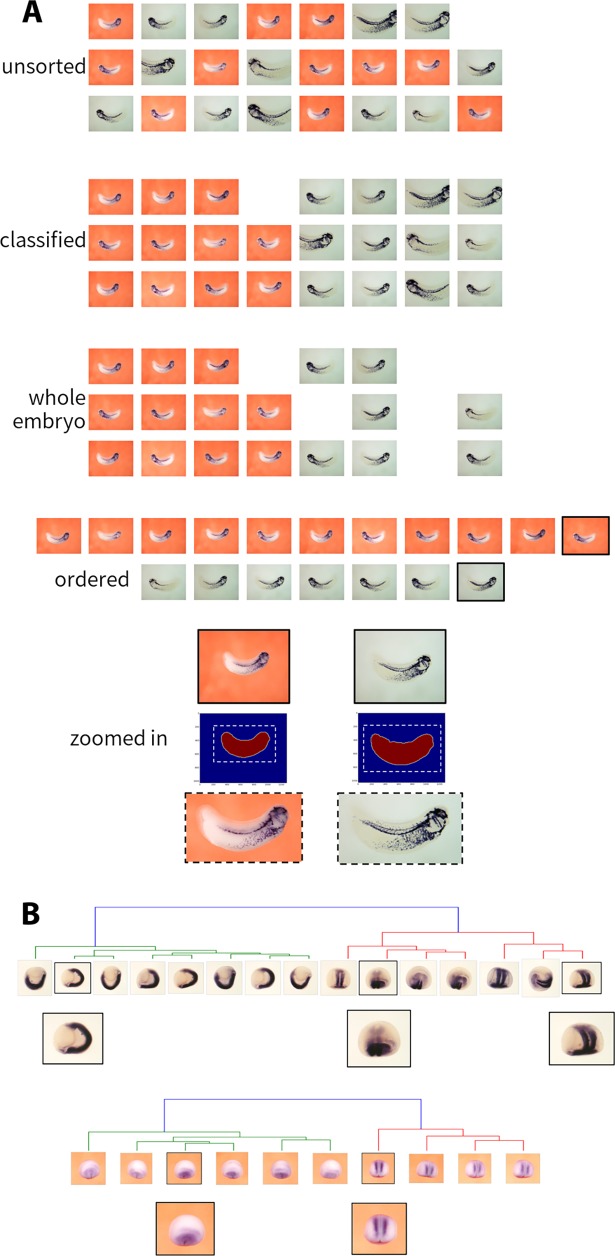
Rational selection of representative images to reduce redundancy.Unsorted images from a large collection for a given gene/development stage are first classified into cleared (grey background) and un-cleared (orange/red background) images. Embryo boundaries were detected within the image and embryo pixel colours analysed to yield predicted in situ stain, pigmentation or unmarked embryo. Embryos with predicted outline touching the image border were excluded (unless the outline in all images in the group touched the border). Images were sorted within groups by stain content for selection, and cropped for display where needed. (A) Lateral view images, NF stage 20+. (B) Quasi-spherical development stages (up to NF stage 20): images are clustered according to expression pattern similarity under rotational and other transformations (see also Fig 4), and the most stained image is selected from each well-separated group.